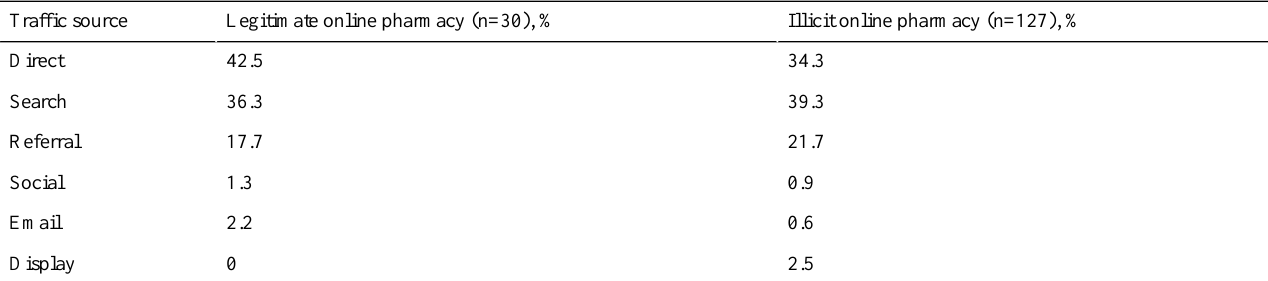
Table 3. Mean percentages of different traffic sources to online pharmacies.